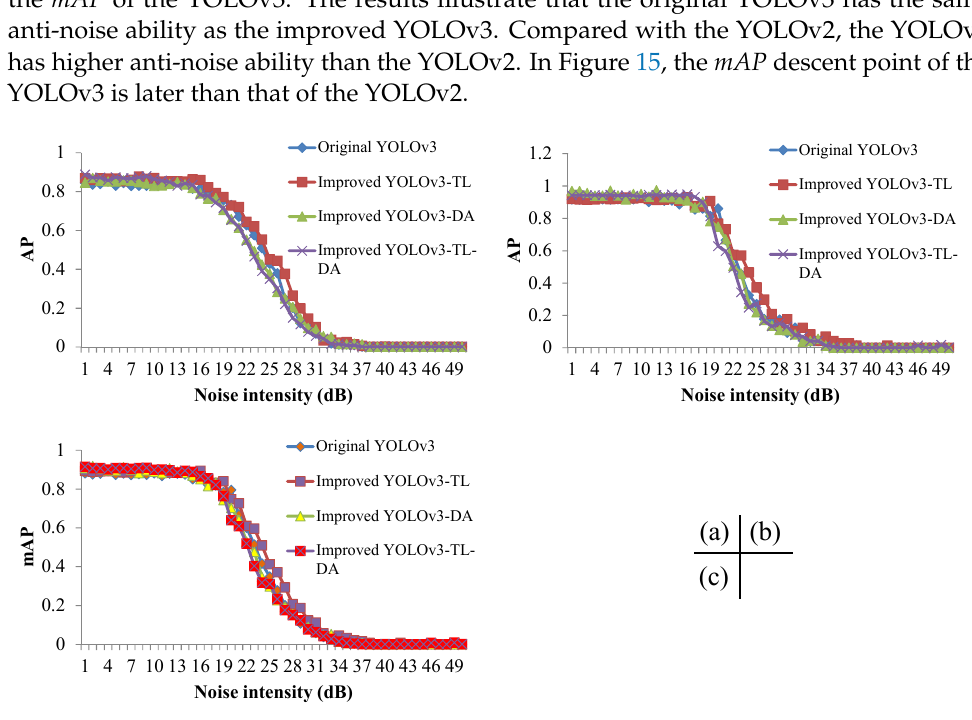
Figure 14. Detection results of the YOLOv3 with influence of noise. ( a ) CR; ( b ) ER; ( c ) the mAP of CR and ER.